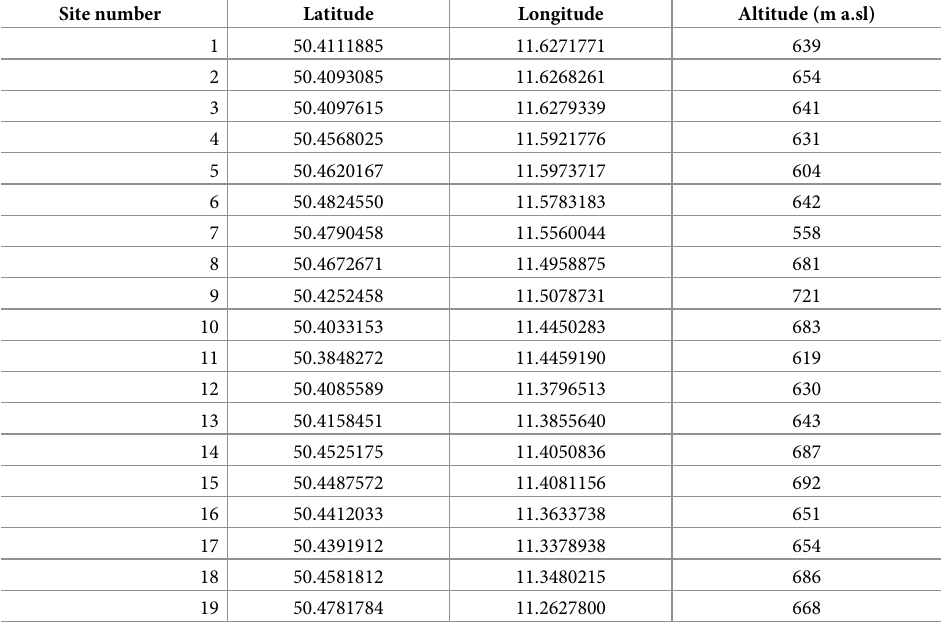
Table 1. Location of the 19 grassland sites. Site number